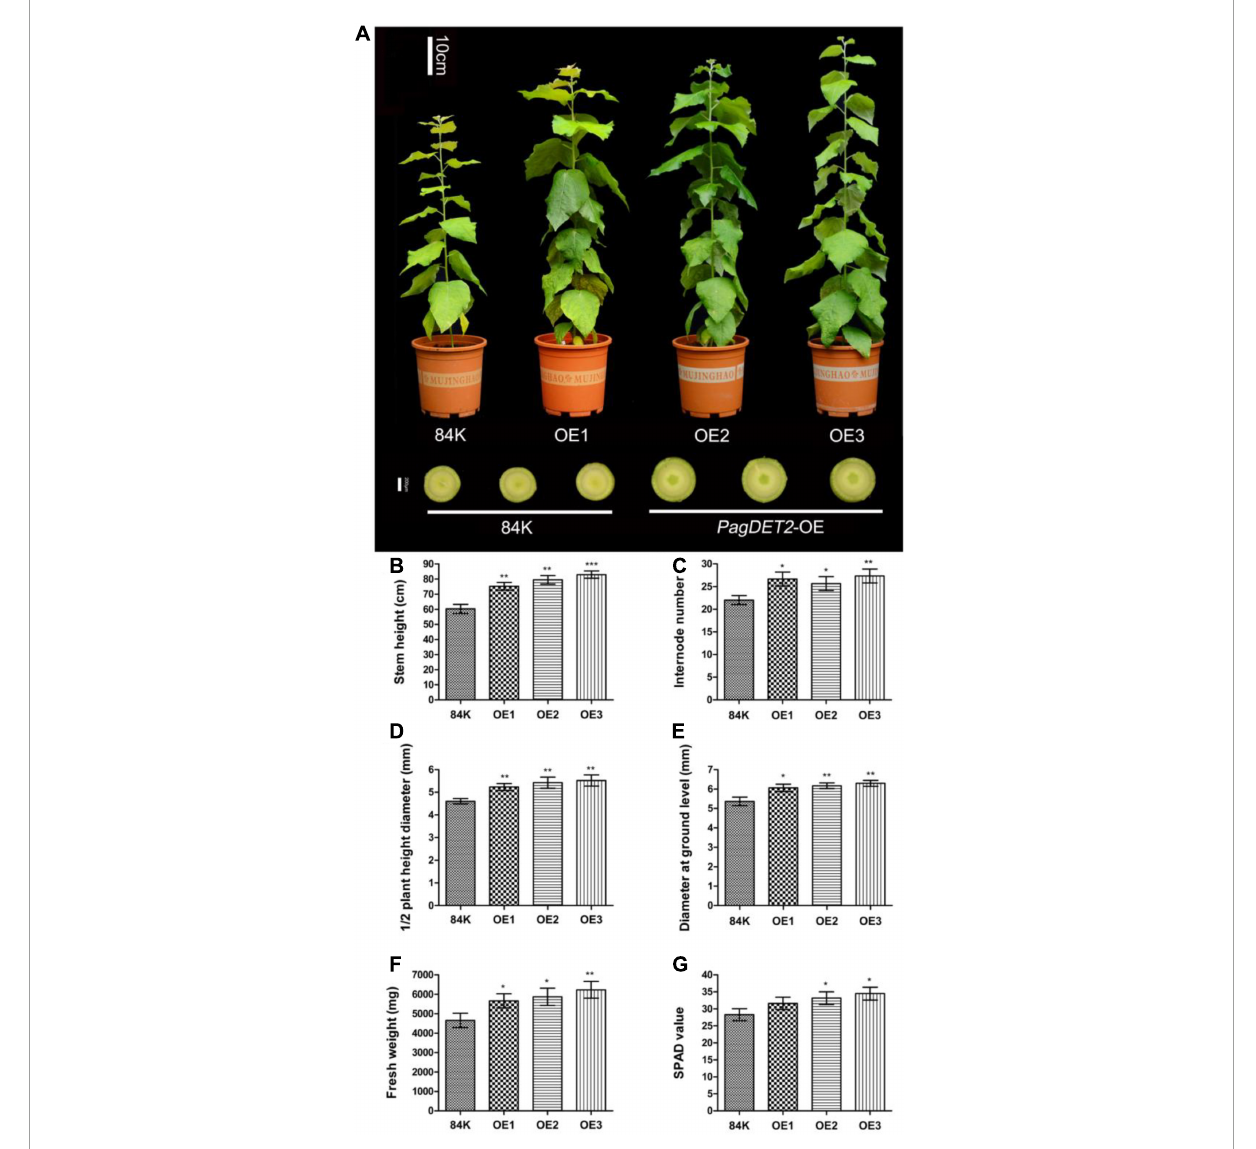
FIGURE3 Growth comparisons of wild-type and PagDET2 overexpression lines. (A) Phenotypes of 90-day-old 84K wild-type and PagDET2 overexpression lines. (B–G) The stem height, internode number, 1/2 plant height diameter, ground diameter, fresh weight, and SPAD value of 84K wild-type and PagDET2 overexpression lines. Mean ± SD. *, **, and *** showed significant difference at P < 0.05, P < 0.01, and P < 0.001, respectively (Student’s t